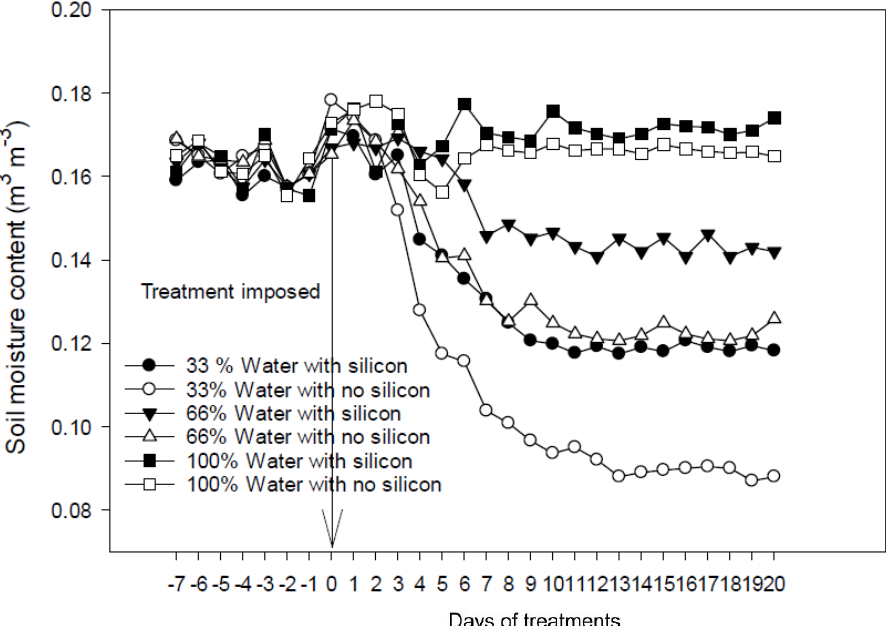
Figure 8. Volumetric soil moisture content in soil growing 7-day-old seedlings under water-limiting conditions. The arrow indicates the day on which water-limiting treatments were imposed.